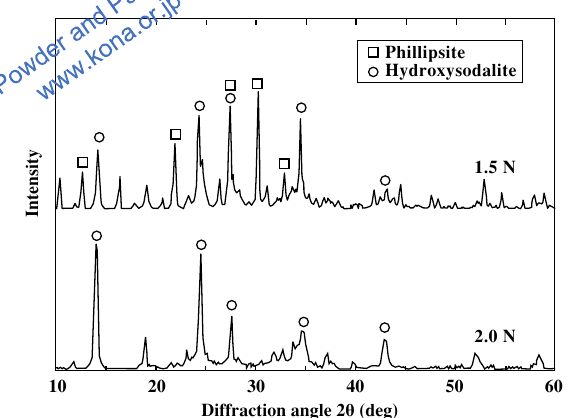
Fig. 9 Peak intensity of products synthesized from pure raw materials as a function of NaOH concentration for various experimental conditions ( ○□ : M Si /M Al = 1.2, K Si /K Al = 0.11, ●■ : M Si /M Al = 1.0, K Si /K Al =